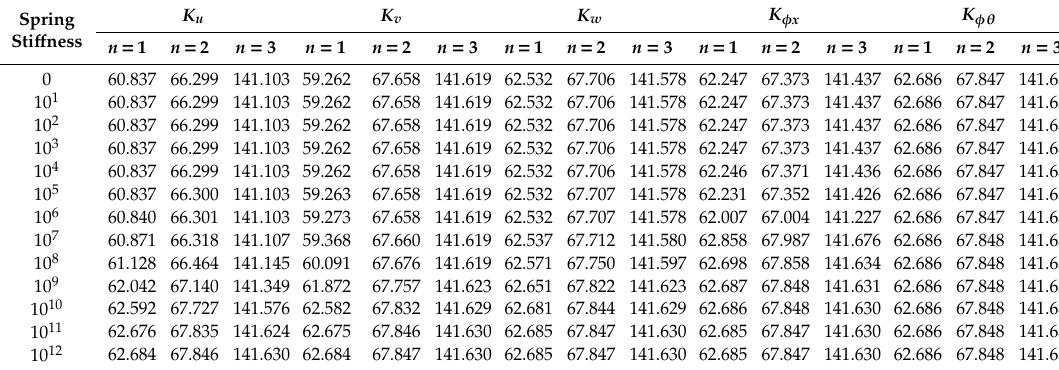
(cid:112) ρ Table 9. The frequency parameters Ω = ω L 2 / E 2 / h for a three-layered cross-ply [0 ◦ / 90 ◦ / 0 ◦ ] composite laminated cylindrical shell with S-elastic boundary conditions, one displacement is under elastic restrained and others are free ( L / R = 4, h / R = 0.1, E 2 = 2 GPa, E 1 / E 2 = 25, µ 12 = 0.25, G 12 = 0.5 E 2 , G 13 = 0.5 E 2 , G 23 = 0.2 E 2 , ρ = 1500 kg / m 3